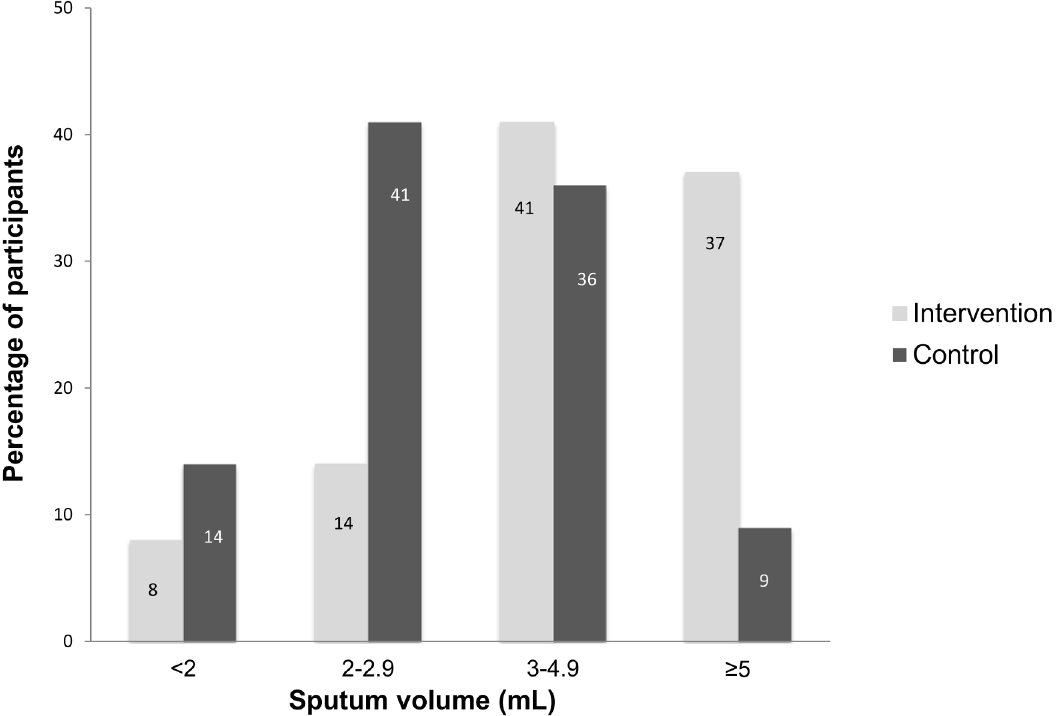
Fig 5. Sputum volume in the intervention (exposure to the sputum submission instruction video) and control group (standard of care). Numbers on the bars indicate absolute number of patients. Overall P value across groups was < 0.0001.